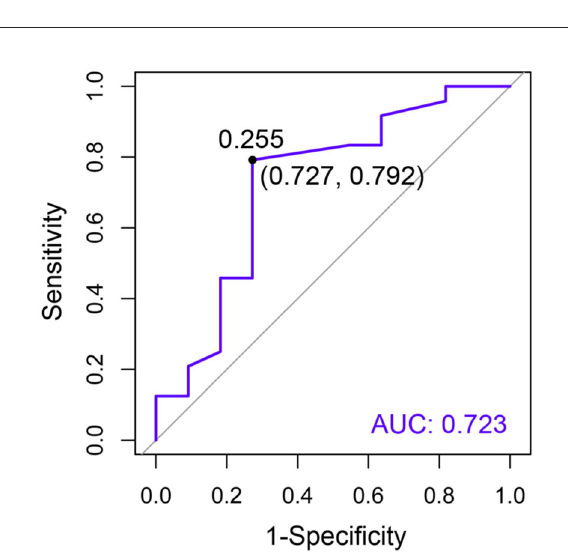
FIGURE7 The receiver operating characteristic (ROC) curve of circulating Bcl-2 for the purposes of CKD diagnosis. The specificity (x-axis) is displayed vs. the sensitivity (y-axis). Moreover, AUC is an area under the ROC